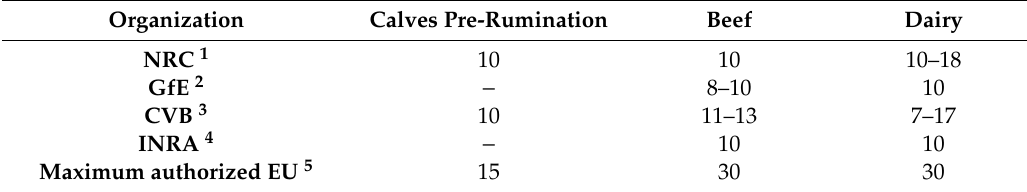
Table 2. Copper requirements (mg / kg DM complete feed) and maximum copper authorised in the European Union for